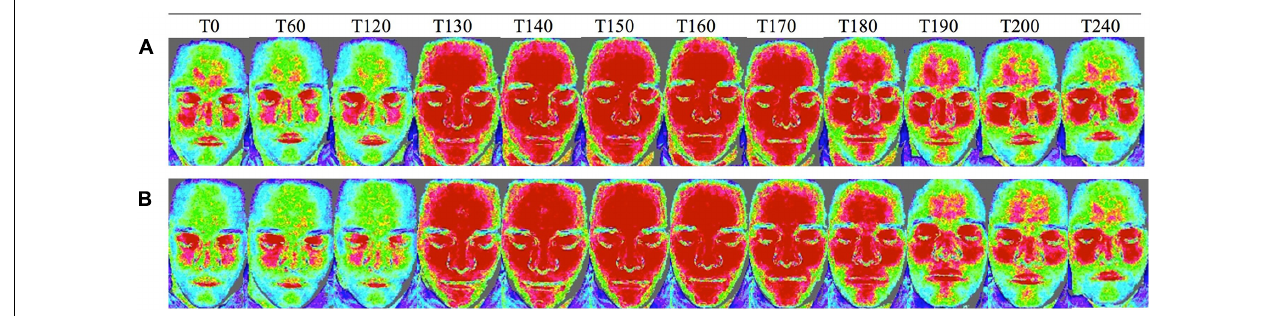
FIGURE 6 | Facial skin blood flow changes measured with laser speckle on (A) glibenclamide-CGRP day and (B) placebo-CGRP day between T 0 and T 240 min . Blue areas indicate low blood flow, green moderate blood flow, and red high blood flow (Kazmi et al., 2015; Ghanizada et al., 2020a). Upon CGRP infusion at T 120 min facial skin blood flow increased on both days.